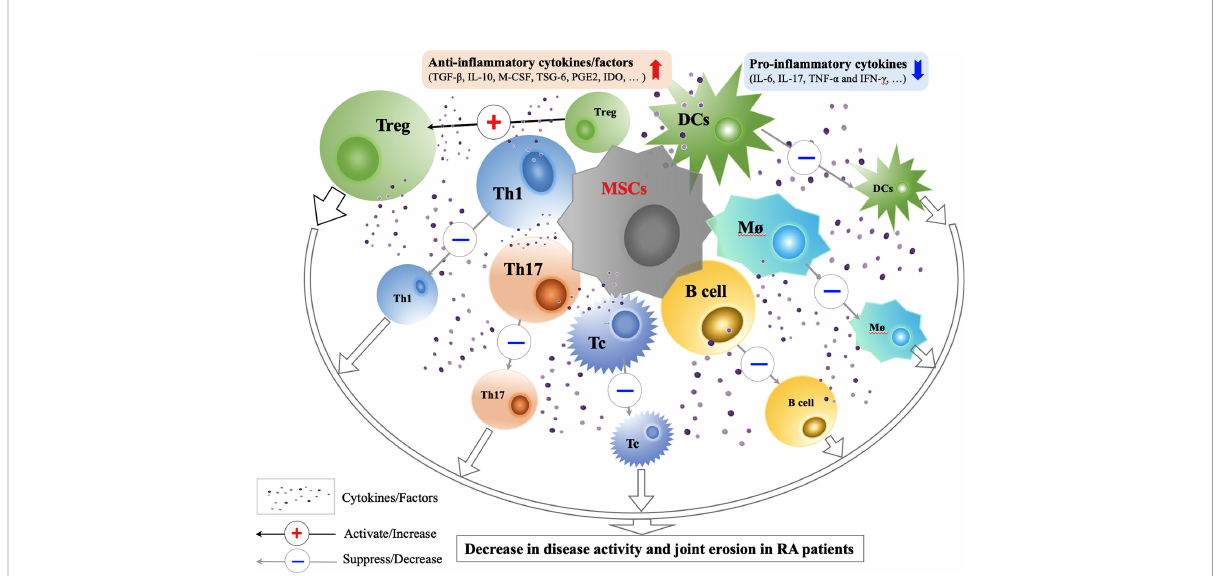
FIGURE 2 Immunological Mechanisms and Effects of MSCs Transplantation in RA Treatment. Through cell-cell contact and secretion of anti-in fl ammatory factors (TGF- b , IL-10, M-CSF, TSG-6, PGE2, IDO and etc.), MSCs can improve the functions of Tregs, suppress the activity of Th1, Th17, Tc, B cells, Mø and DCs, correct the immune imbalance between Treg and Th17, and restore the immune tolerance in RA. Animal and preliminary clinical studies on ef fi cacy and safety of MSCs transplantation in RA treatment show that the use of MSCs treatment in RA patients are promising. CCP, cyclic citrullinated; CPR, C-reactive protein; DAS, disease activity score; DCs, dendritic cells; IDO, indoleamine-2,3- dioxygenase; INF, interferon; M-CSF, macrophage colony stimulating factor; MSCs, mesenchymal stem cells; Mø; macrophage; PGE2, prostaglandin E2; Tregs, regulatory T cells; Tc, cytotoxic T cell; TGF, transforming growth factor; TNF, tumor necrosis factor; TSG-6, TNF- stimulated gene-6